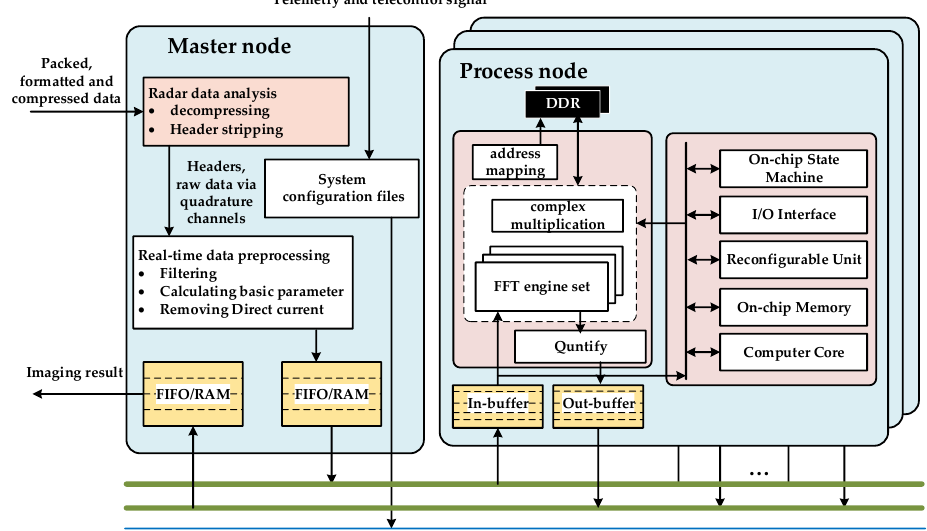
Figure 8. Block diagram of the multi-node parallel system architecture.